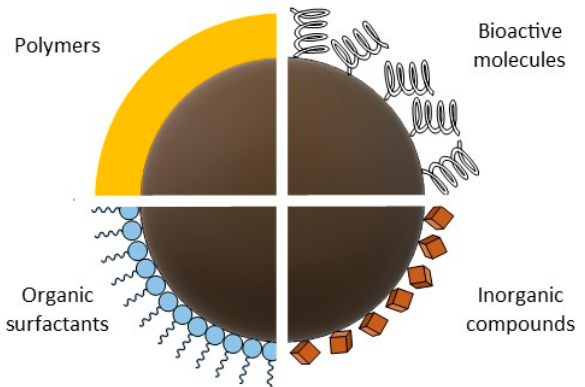
Figure 5. Schematic illustration of the main shells for functionalization of iron oxide magnetic nanoparticles (MNPs).